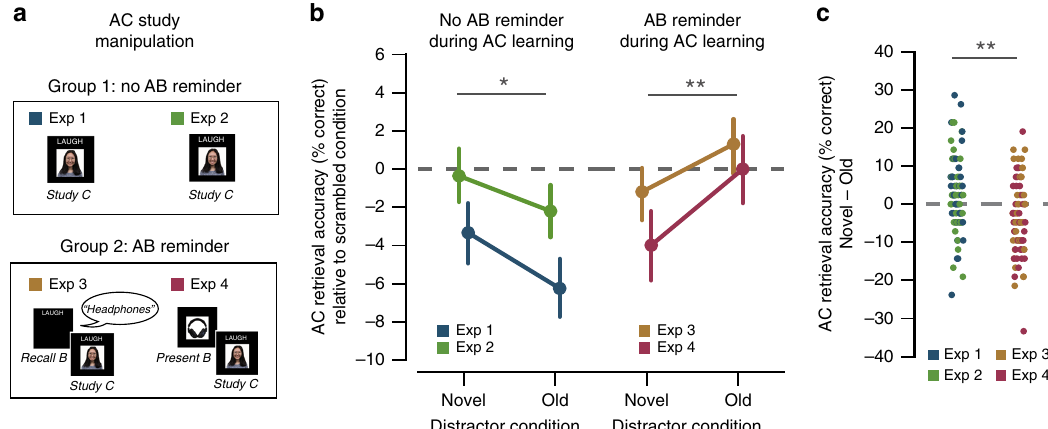
Fig. 2 Encoding factors in fl uence interference during retrieval. a Illustration of the AC Study manipulations across Experiments 1 – 4. In Experiments 1 and 2, AC pairs were studied without explicit reminders of AB associations. In Experiment 3, subjects retrieved each AB association immediately prior to studying overlapping AC associations. In Experiment 4, each B image was brie fl y presented (200 ms) immediately prior to the presentation of each overlapping AC Study trial. b AC retrieval accuracy across Experiments 1 – 4. For standardization across experiments, the Scrambled condition is used as a baseline, with accuracy in the Novel and Old conditions shown relative to this baseline (see Supplementary Table 2 for all accuracy values). When there were no explicit reminders of AB associations during AC Study (Experiments 1 and 2; left columns), AC retrieval accuracy was signi fi cantly worse in the Old condition (B image as distractor during AC Test) than the Novel condition (novel image as distractor during AC Test). However, when there were explicit reminders of the B image during AC Study (Experiments 3 and 4; right columns), this pattern was reversed: AC retrieval accuracy was higher in the Old condition than the Novel condition. Thus, reactivating B images during AC Study signi fi cantly attenuated interference between AB and AC associations during retrieval. c Distribution of the difference scores in AC retrieval accuracy for the Novel vs. Old conditions for Experiments 1 – 4. Individual dots represent the difference scores (Novel – Old) for individual subjects. Notes: Error bars re fl ect s.e.m.; ** p < 0.01, * p < 0.05 by